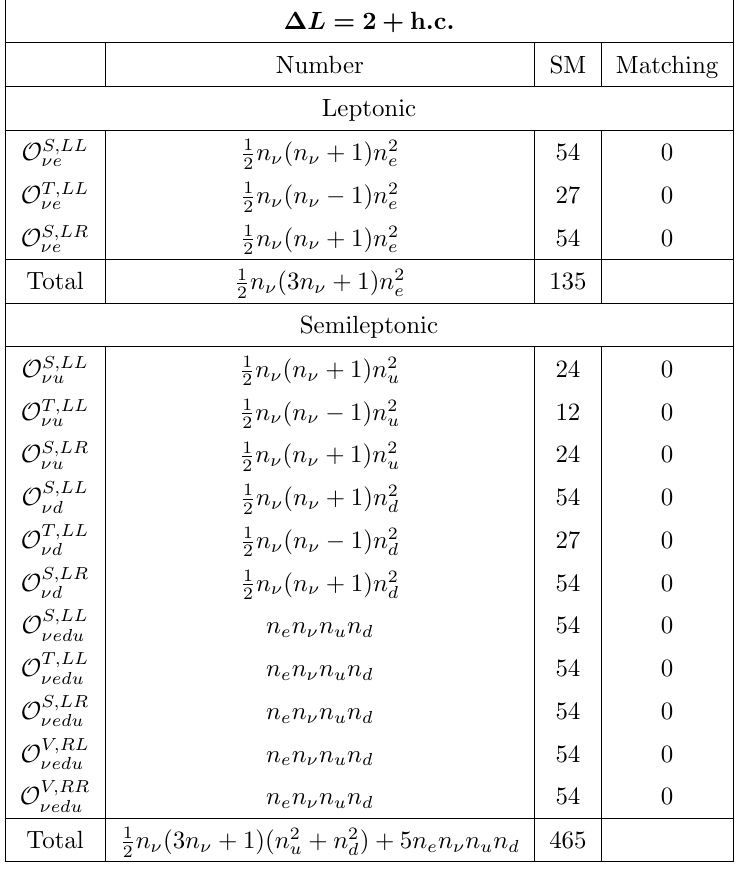
Table 19 . Dimension-six ∆ L = 2 operators in LEFT. There are also Hermitian conjugate opera- tors, as indicated in the table heading. The operators are divided into leptonic and semileptonic operators. The second column is the number of operators for an arbitrary number of neutrino flavors n ν , charged lepton flavors n e , u -type quark flavors n u , and d -type quark flavors n d , and the third column is the number in the SM LEFT with n ν = 3, n e = 3, n u = 2, and n d = 3. The last column is the tree-level matching coefficient in